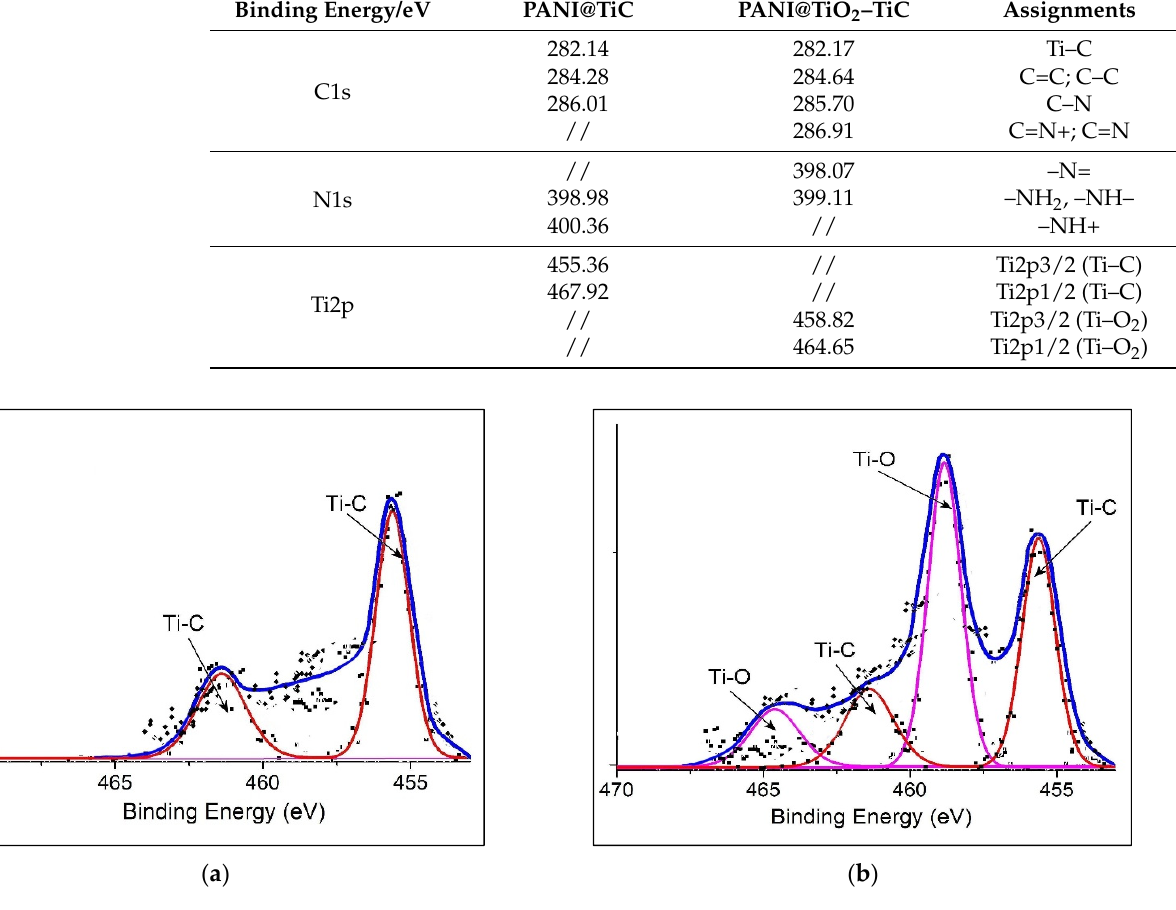
Figure 2. XPS spectra for Ti2p signals of: ( a ) TiC and ( b ) TiO 2 –TiC.